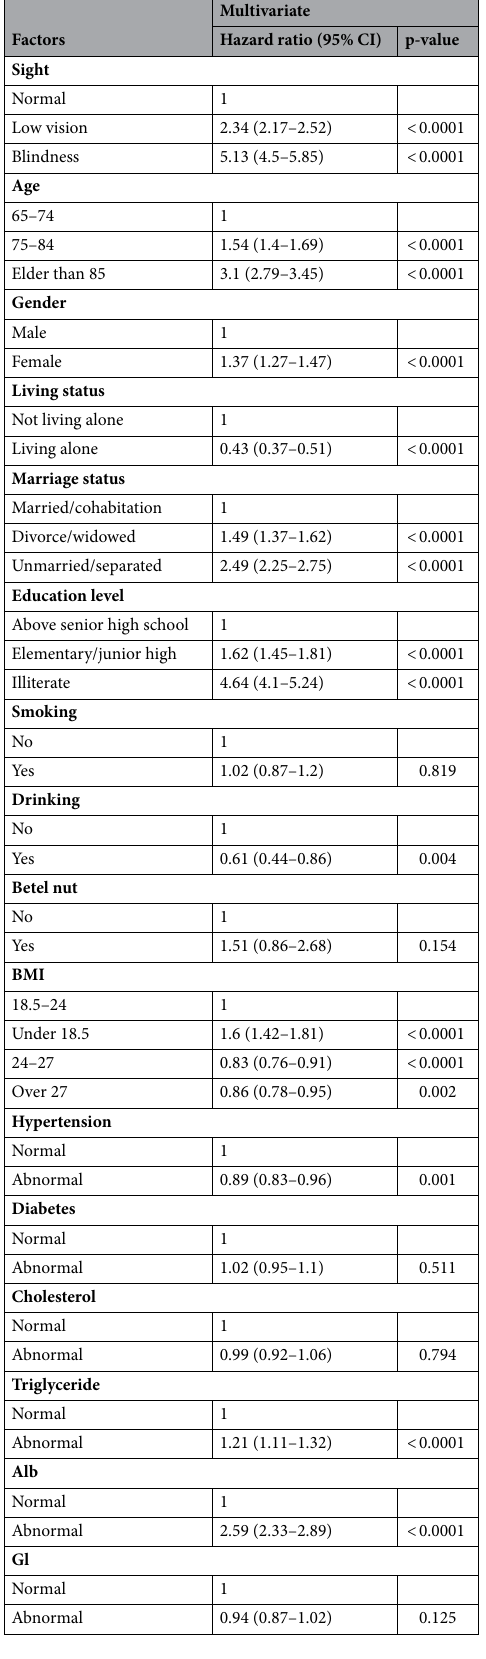
Table 3. Multivariate Cox proportional model of factors associated with potential cognitive decline as demonstrated by abnormal